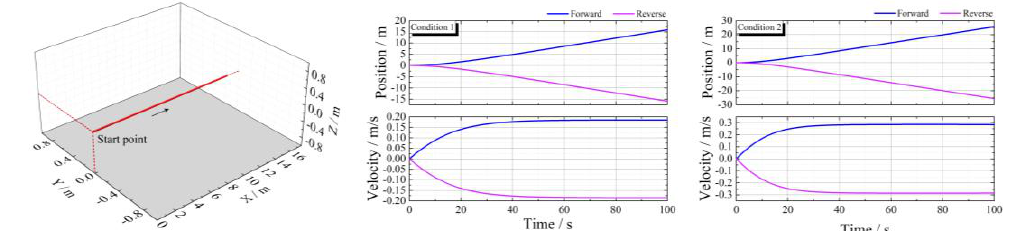
Figure 10. Simulation tests for forward and backward rectilinear motion, which contain the trajec- tories, position and velocity under condition 1, and position and velocity under condition 2. Note that position and velocity are in the inertial reference